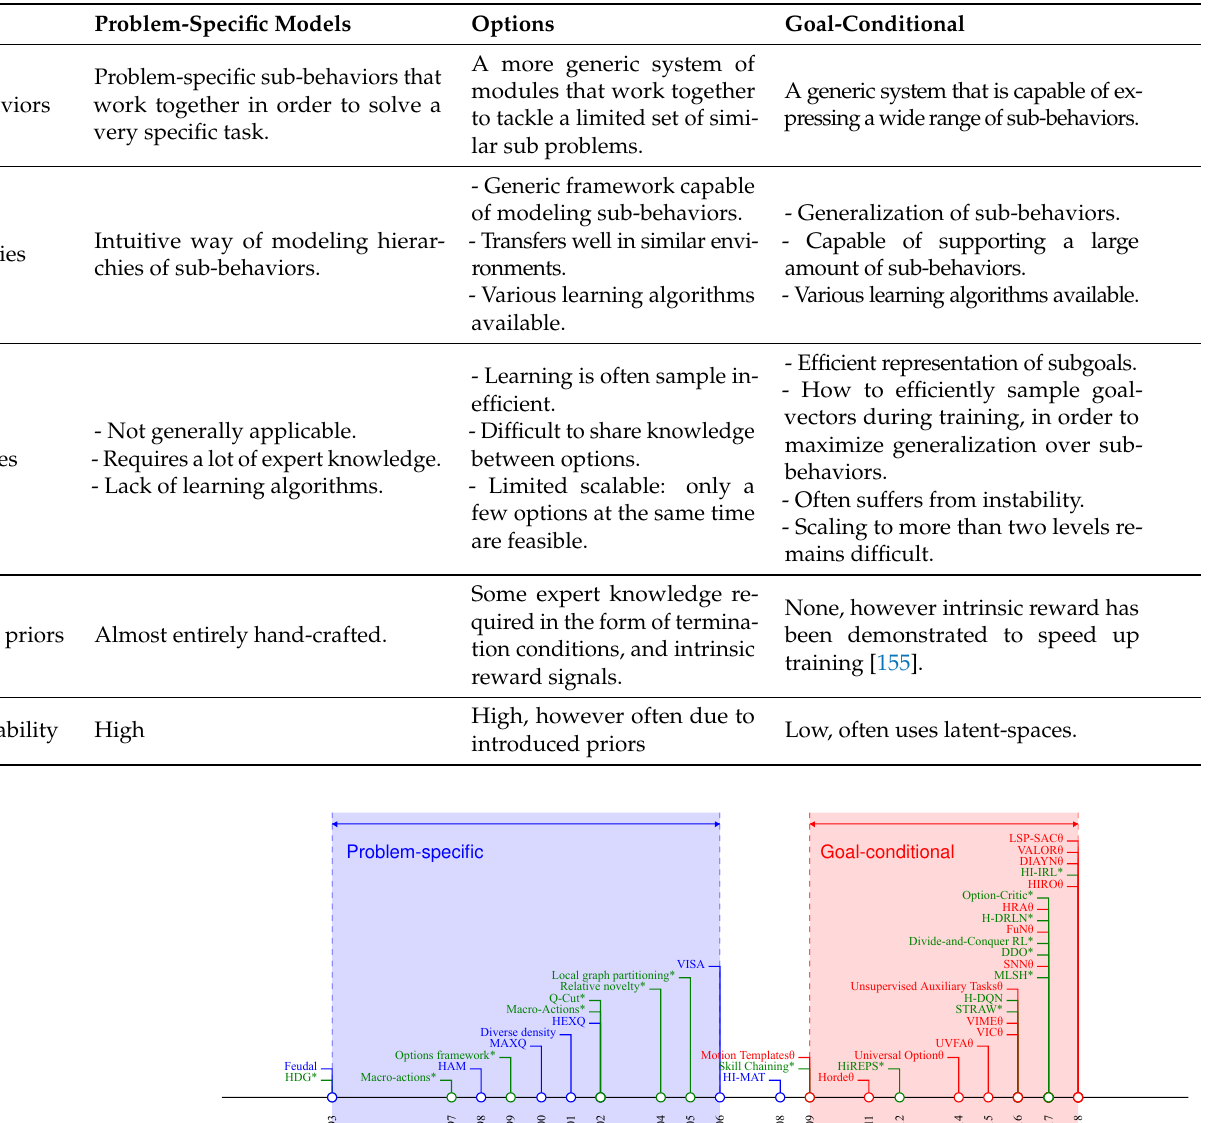
Table 1. Summary table of the reviewed HRL frameworks.